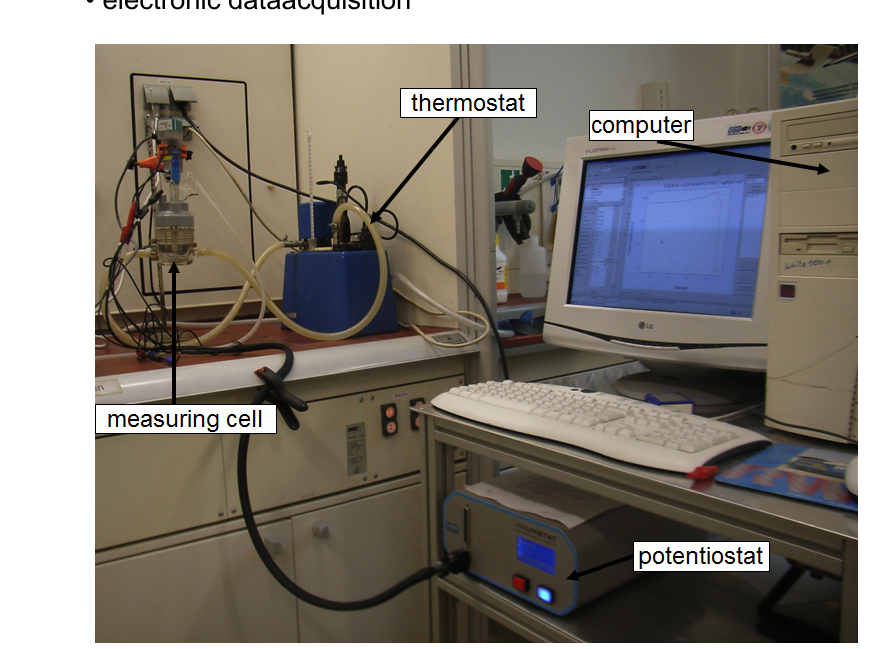
Figure 12 – Experimental setup for the electrochemical measurement Рис . 12 – Экспериментальное оборудование для электрохимических измерений Slika 12 – Eksperimentalna oprema za elektrohemijsko